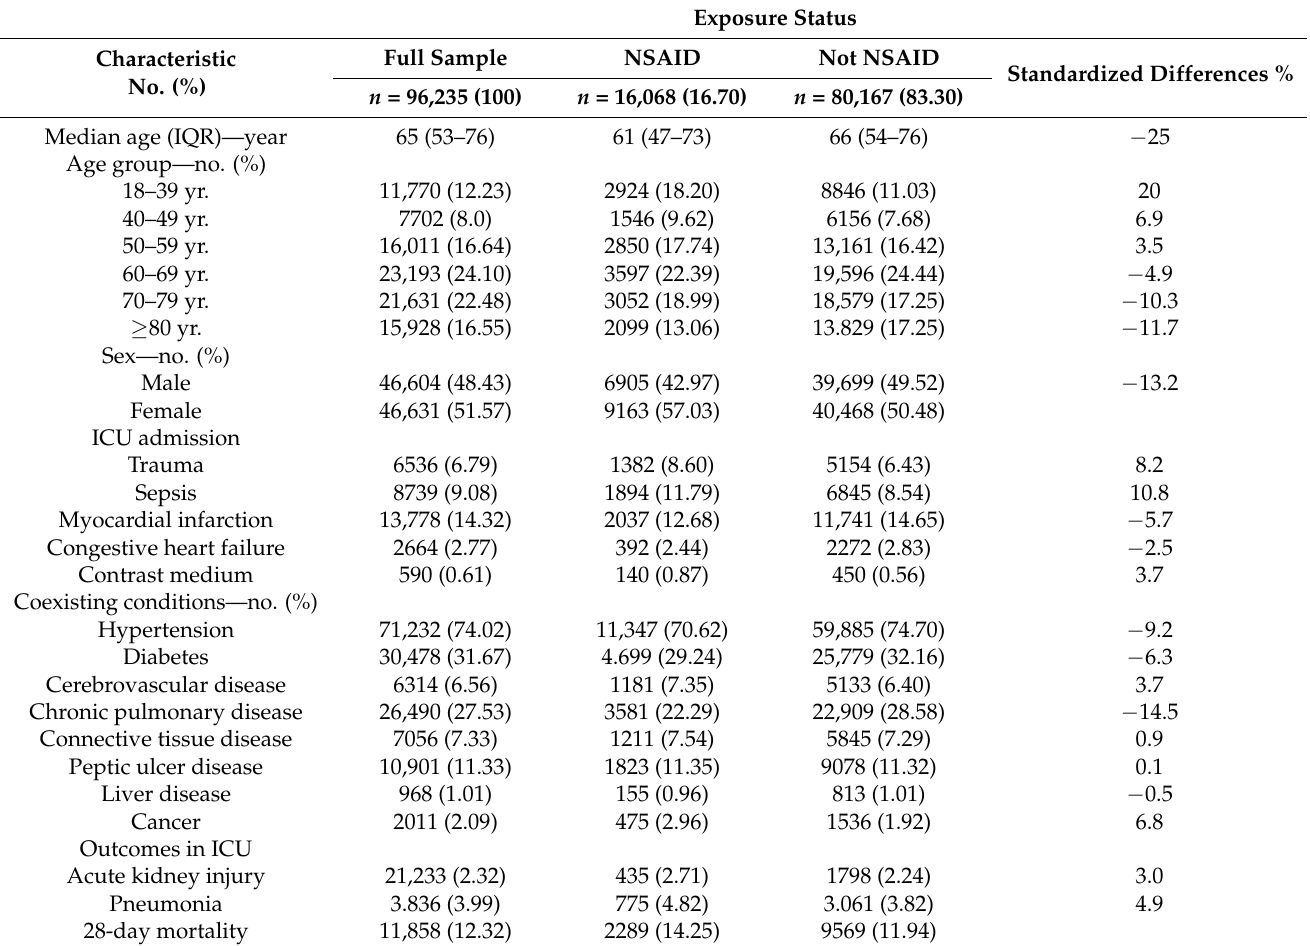
Table 1. General characteristics of patients admitted to the ICU from 2018 in 180 units in Colombia.